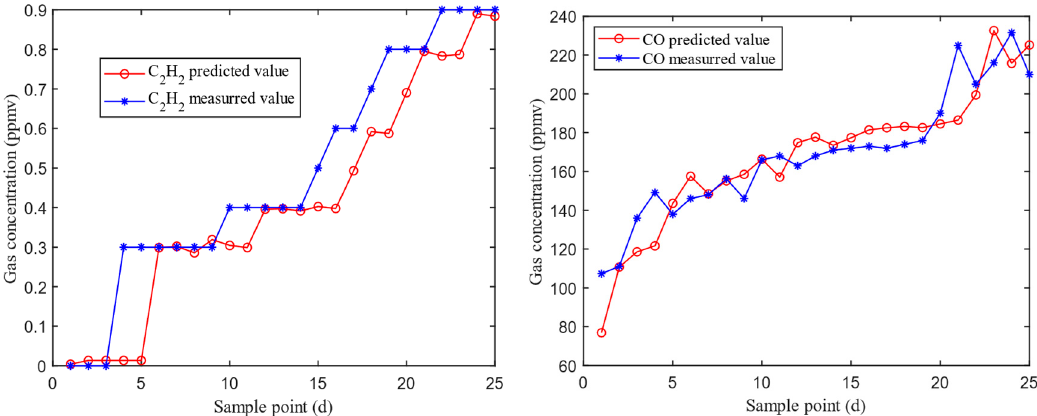
Figure 6. The predicted vs. measured DGA data of C 2 H 2 and